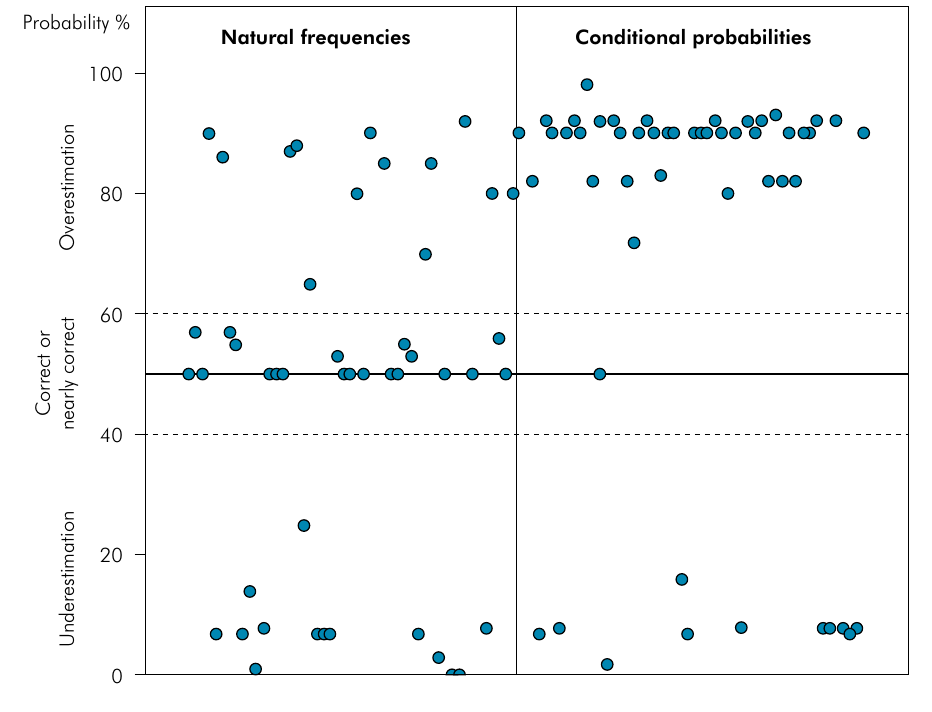
Figura 2. Answers given by all the dentists according to the format in which they received the diagnostic test accuracy information. The correct answer in this hypothetical scenario was 50%, the nearly correct answers 40%-49% or 51%-60%, underestimation less than 50% and overestimation greater than 50%. From Nadanovsky et al. 10 with permission.